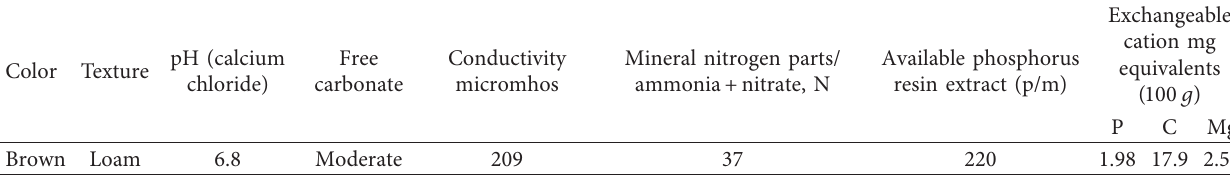
Table 1: Site soil characterisation at The Future of Hope Foundation research site. pH (calcium Color Texture